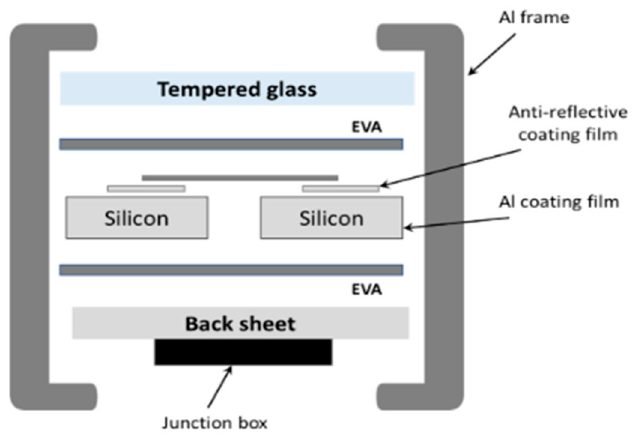
Figure 1. Cross-sectional view of the typical structure of the c–Si photovoltaic (PV) module.